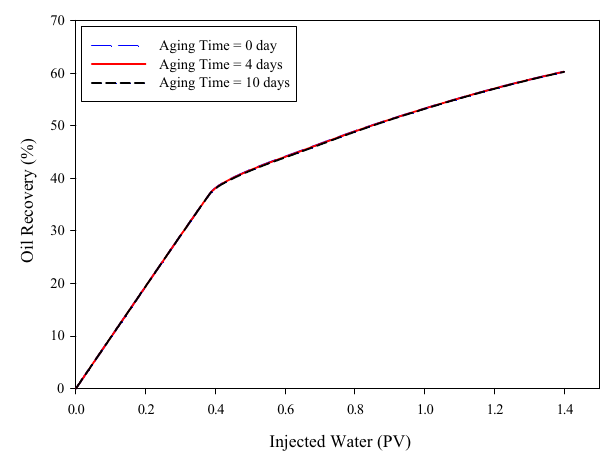
Fig. 10 Well water cut, oil recovery and average field pressure versus time for model #2